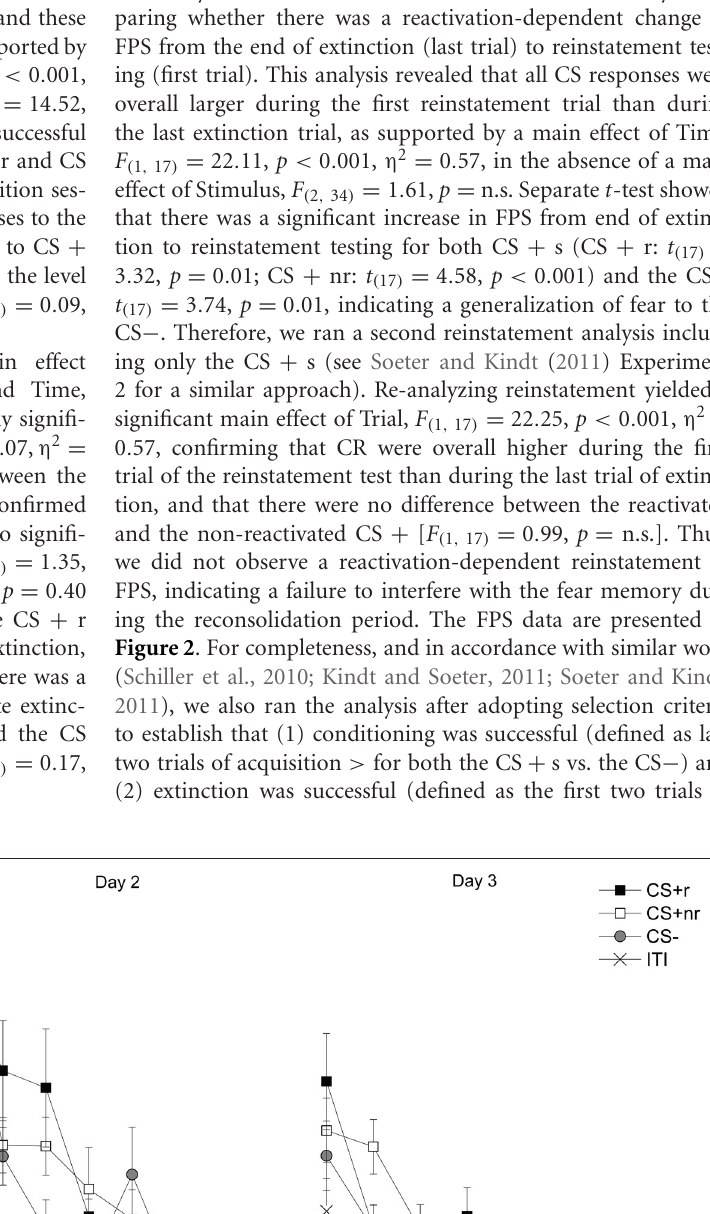
FIGURE 2 | Experiment 1: Reactivation of fear-relevant stimuli indexed by fear potentiated startle responses (FPS). Mean startle response elicited during the presentation of the fear conditioned stimuli (CS + r, CS + nr), the control stimulus (CS − ), and during the inter-trial intervals (ITI) during